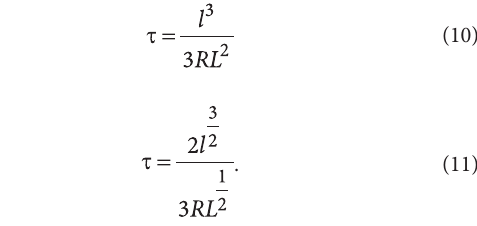
Fig. 2. Curvature change from 2 nd degrees (downward